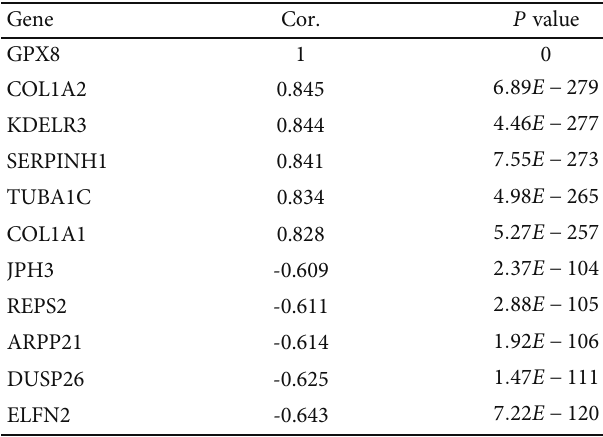
Table 2: Description of ten coexpressed genes showed in Figure